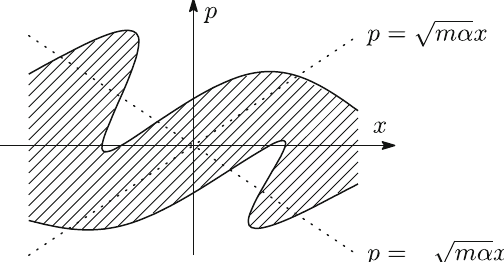
of the droplet have the multiple values as functions of x , P + ( x , t ) and P − ( x , t ) are not enough to define the boundaries. Such a multiple value configuration is called “fold” [37,65] and the hydrodynamic Eq. (3.1) does not work there [63,66]. We do not consider this case in this article